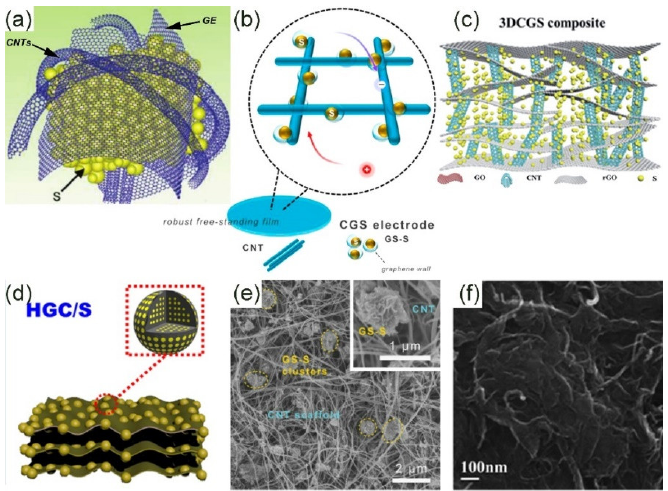
Figure 9. Various carbon/G composite cathode configurations. ( a ) Schematic diagram of G/CNT hybrid [142]. Copyright 2017, John Wiley and Sons. Schematic diagram of ultra-long CNT/GS-S structure ( b ) and its SEM image ( e ) [141]. Copyright 2015, Elsevier. 3DCGS composite cathode structure ( c ) and its SEM image ( f ) [143]. Copyright 2015, Royal Society of Chemistry. ( d ) Graphene and carbon nanospheres structure diagram [144]. Copyright 2019,